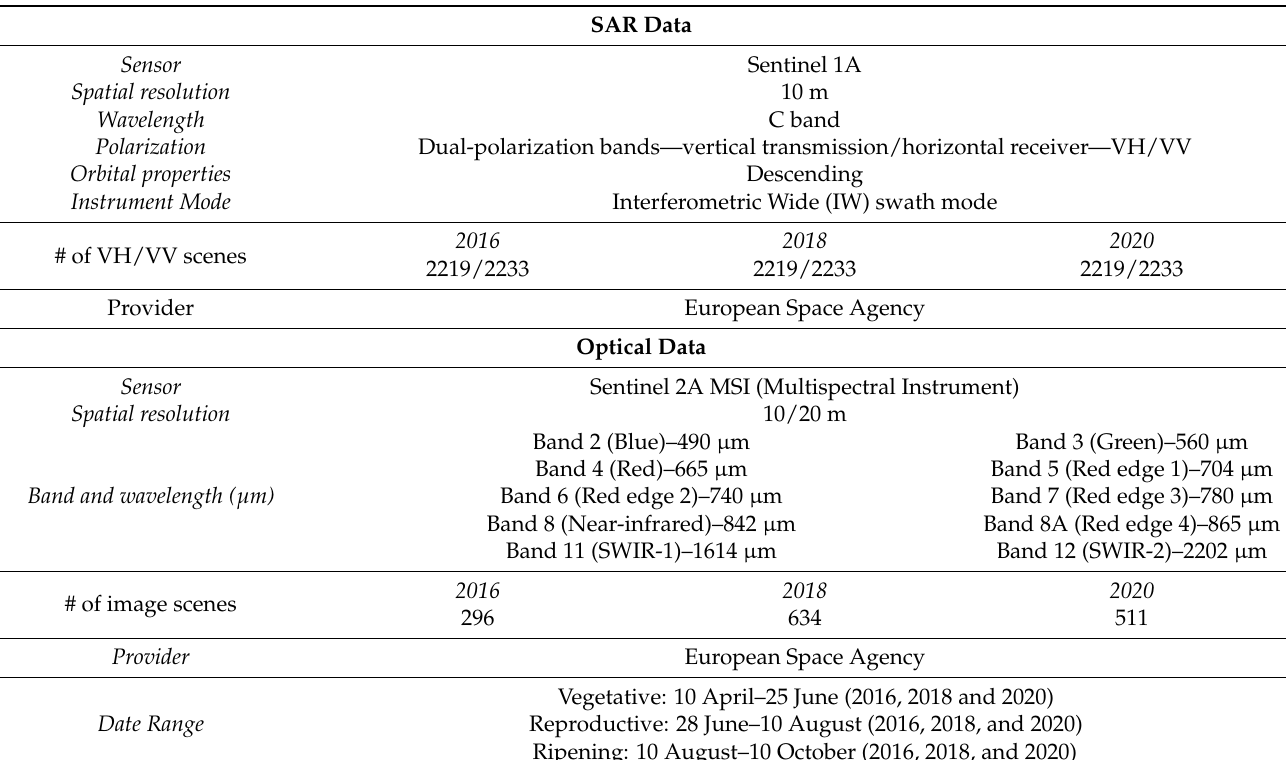
Table 1. Description of satellite data (Sentinel-1 SAR and Sentinel-2 optical imagery) used in the